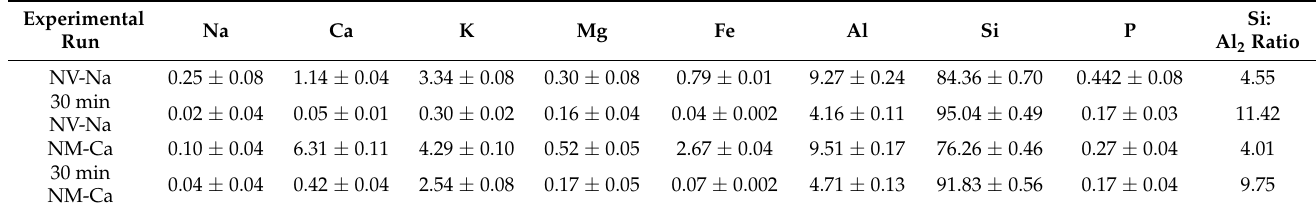
Table 3. The XRF data for zeolites in mole %.